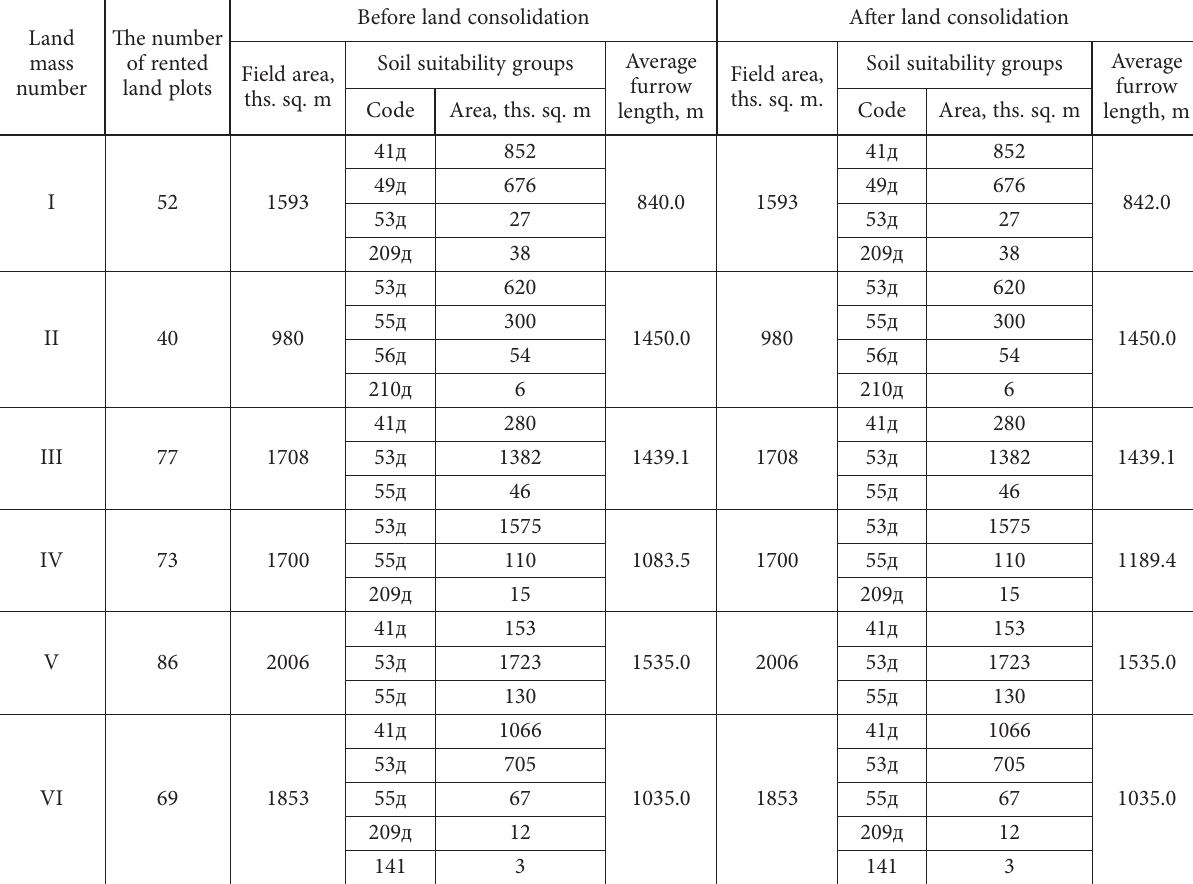
Table 3. Agricultural enterprise land tenure characteristics (option